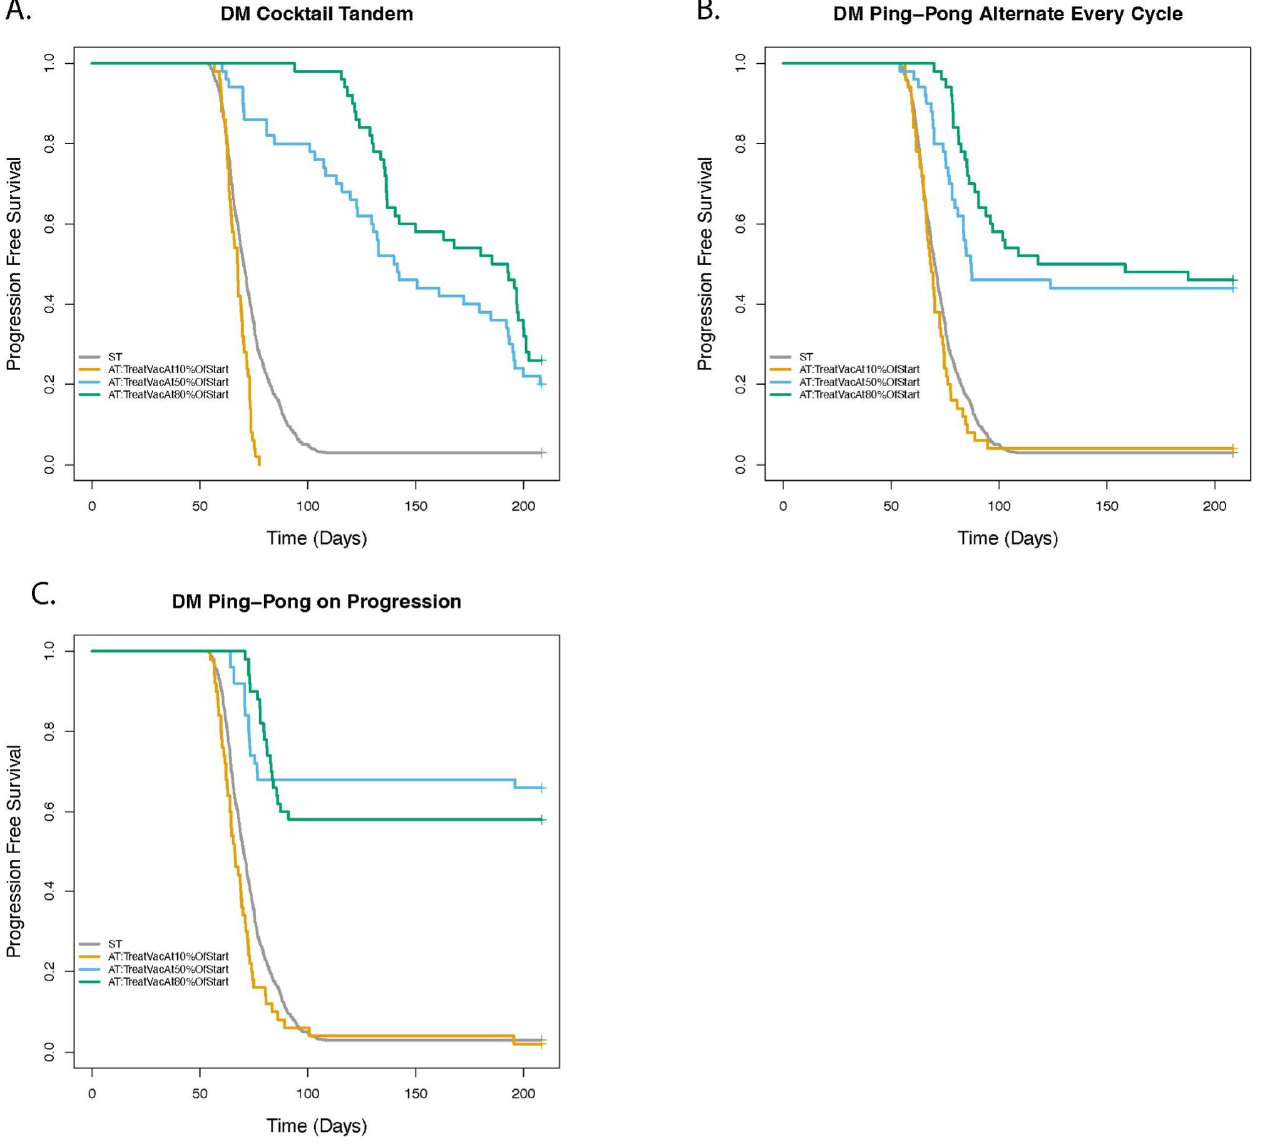
Figure 10. The effect of stopping treatment when the tumor burden falls below some threshold. The panels show the comparison of adaptive therapy (AT) versus standard treatment (ST) as the treat- ment vacation parameter is varied for ( A ) DM Cocktail Tandem, ( B ) DM Ping-Pong Alternate Every Cycle, ( C ) DM Ping-Pong on Progression. In the DM protocols, doses are adjusted as the tumor